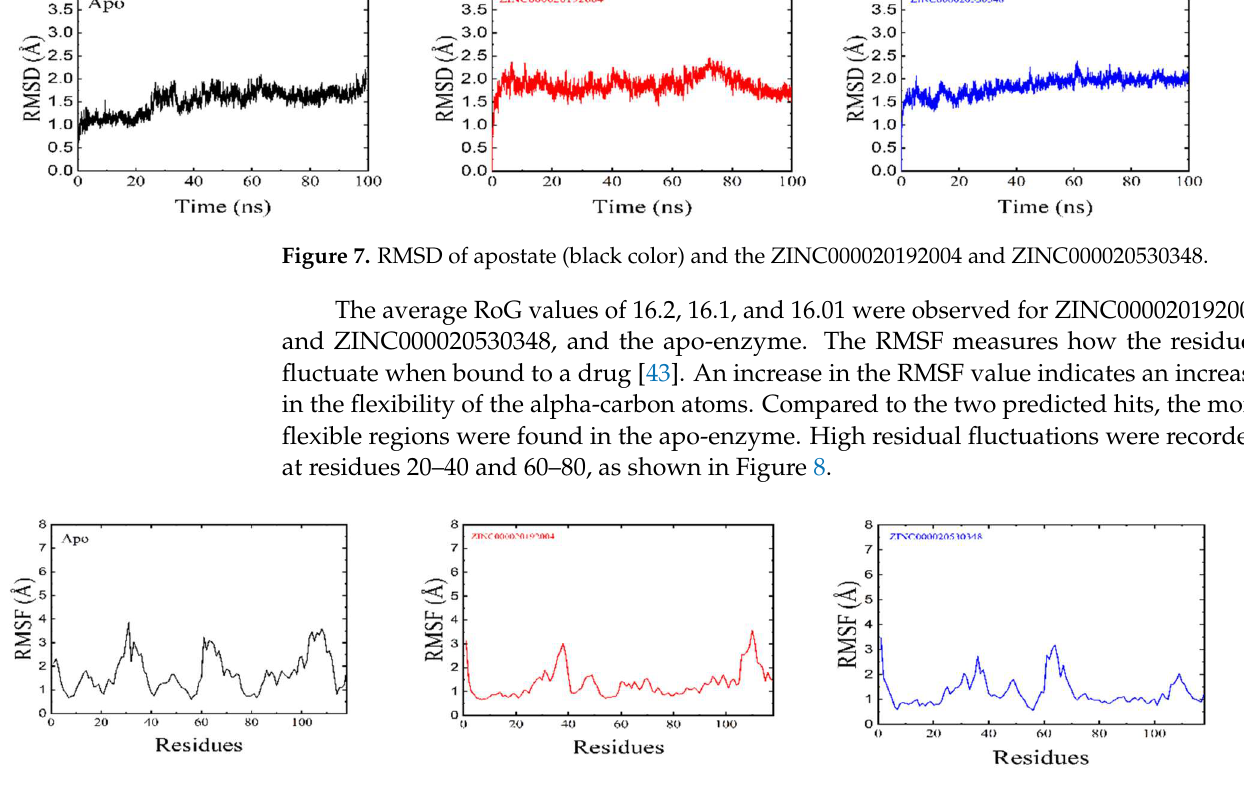
Figure 9. RoG of the apostate, ZINC000020192004 and ZINC000020530348. The number of frames is shown on the x-axis. 4. Conclusions In the present study, we utilized the art of computational biology to identify novel therapeutic targets in S. lugdunensis proteome. Through subtractive proteomic analysis, novel drug targets involved in unique metabolic pathways were identified by using com- parative sequence analysis and different biological updated databases. The prioritized therapeutic targets, including 4-hydroxtetrahydrodipicolinate reductase, signal pepti- dase, DNA-binding response regulator, and genome polyprotein, are critical to the path- ogen’s survival. The drug target predicted in the present study was promising to be es- sential to the pathogen survival and did not share homology with the human gut micro- biota. The three-dimensional structure of the DNA-binding response regulator-protein was subjected to molecular docking studies, and it evaluated ZINC000020192004 and ZINC000020530348 as lead compounds. These compounds showed striking interactions with the DNA-binding response regulator. Furthermore, the results of the MD simulation analysis demonstrated that the two hits, ZINC000020192004 and ZINC000020530348, re- mained stable with the active site residues of the DNA-binding response-regulator pro- tein. Further in vitro study is needed to validate these drug targets and the lead com- pounds.